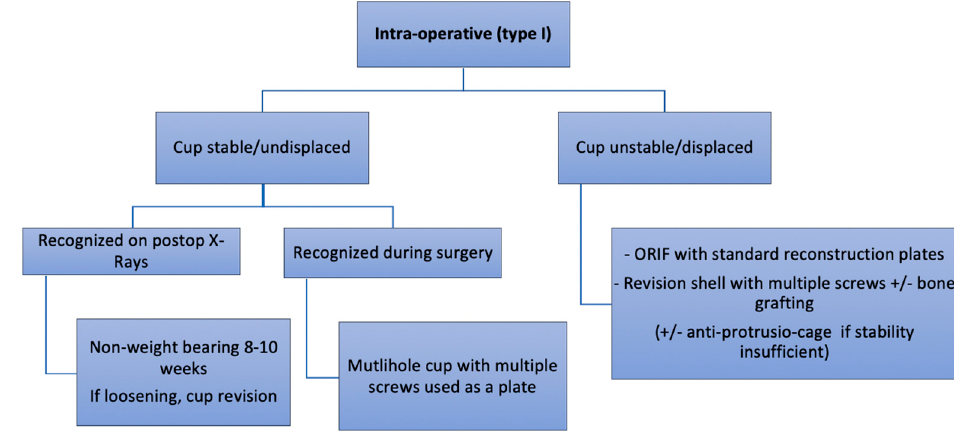
Figure 6. Authors preferred treatment algorithm for intra-operative fractures.